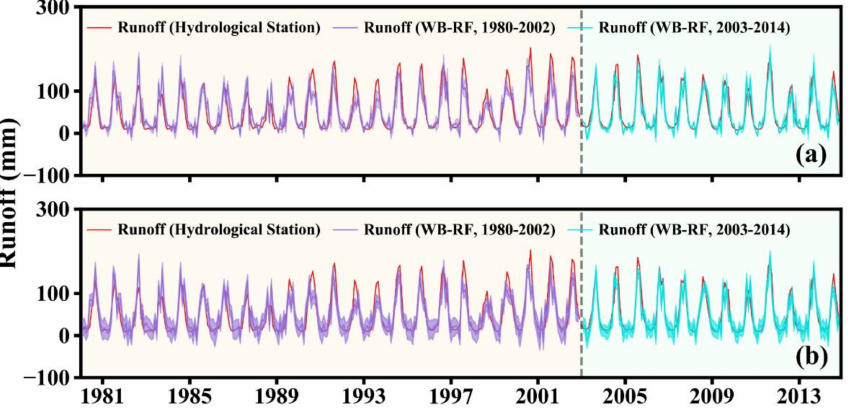
Figure 11. Monthly estimated discharge using the WB-RF. ( a , b ) correspond to the uncertainty in the precipitation and ET components in the water balance method, respectively.